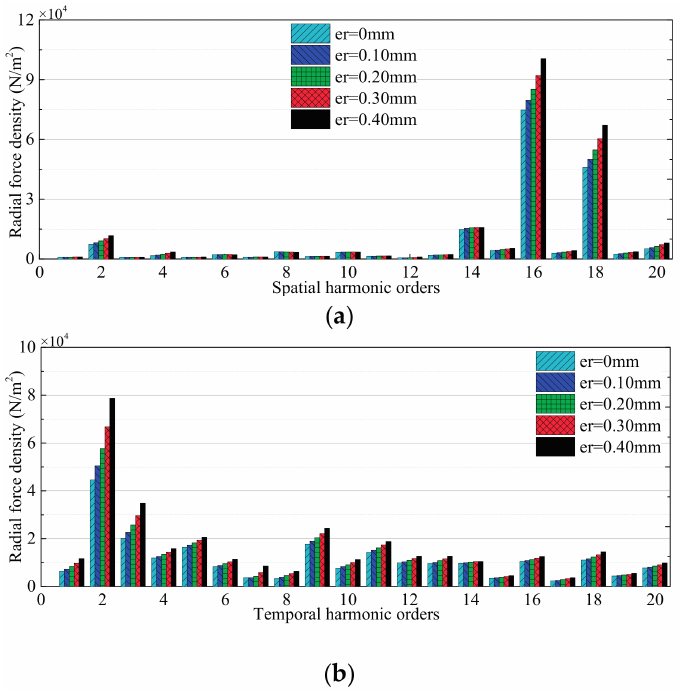
Figure 12. Harmonic contents of radial force density in the IPMSM with rotor deformation at no-load condition. ( a ) Spatial harmonics; ( b ) Temporal harmonics.